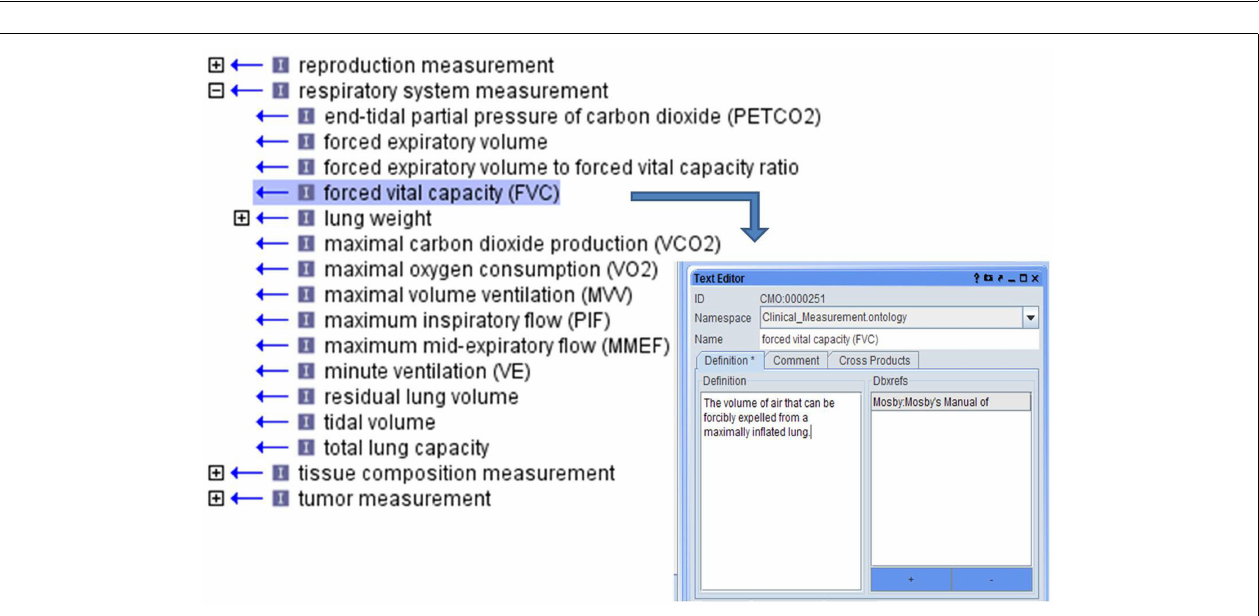
FIGURE 2 |The Clinical Measurement Ontology is presented in a hierarchical structure with classes lower down a branch being subclasses of those above with an “is_a” relationship.